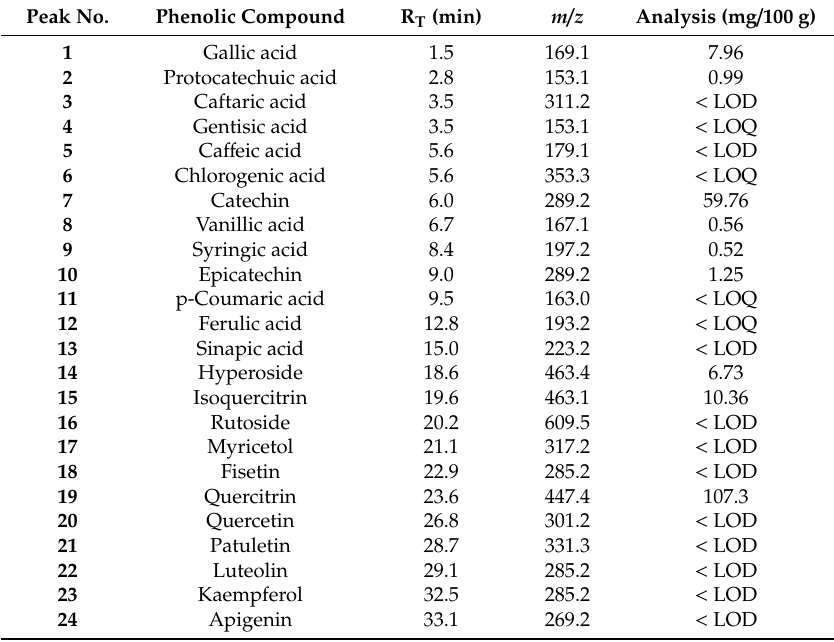
LOD – limit of detection; LOQ – limit of quantification; R T – retention